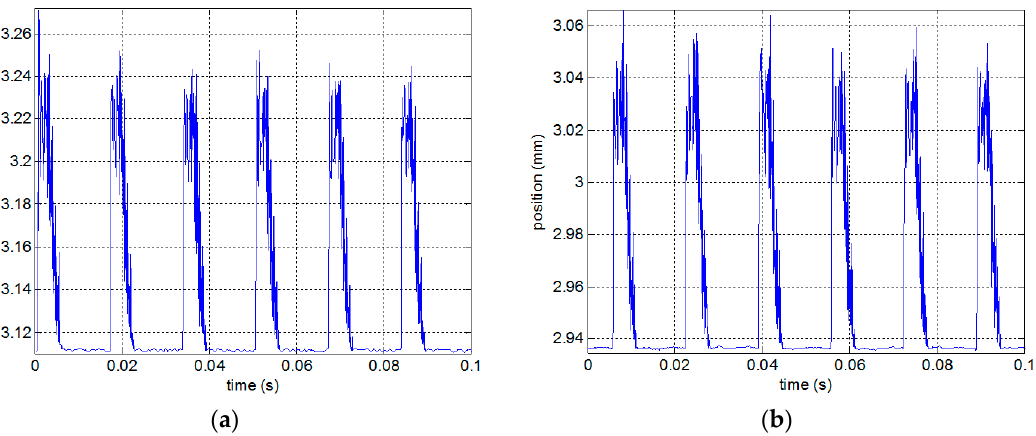
Figure 9. PSD output signals without signal processing. ( a ) Original signals for the X − direction; ( b ) original signals for the Y − direction.